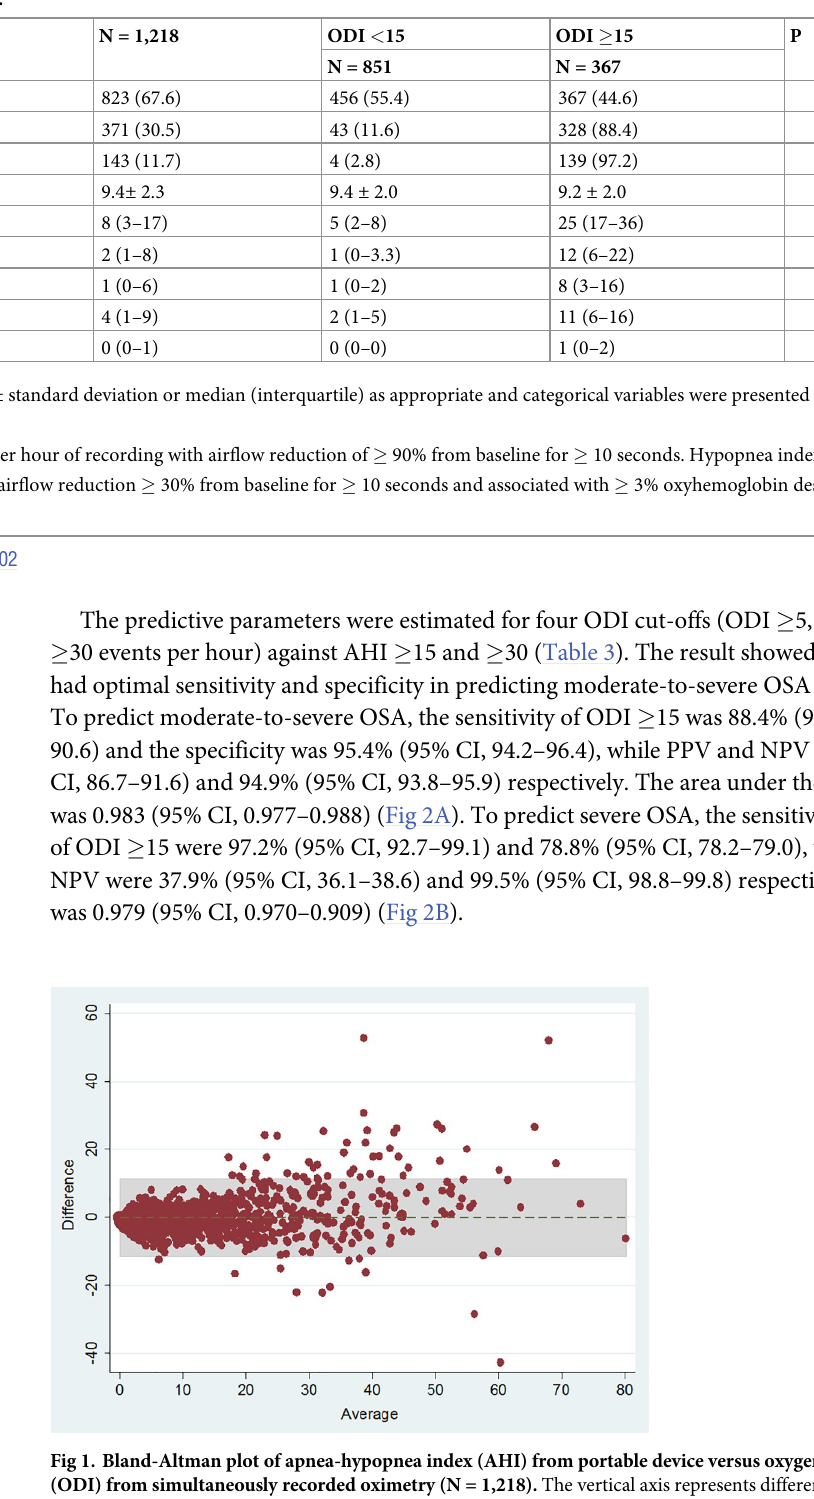
Table 2. Sleep study parameters of patients.